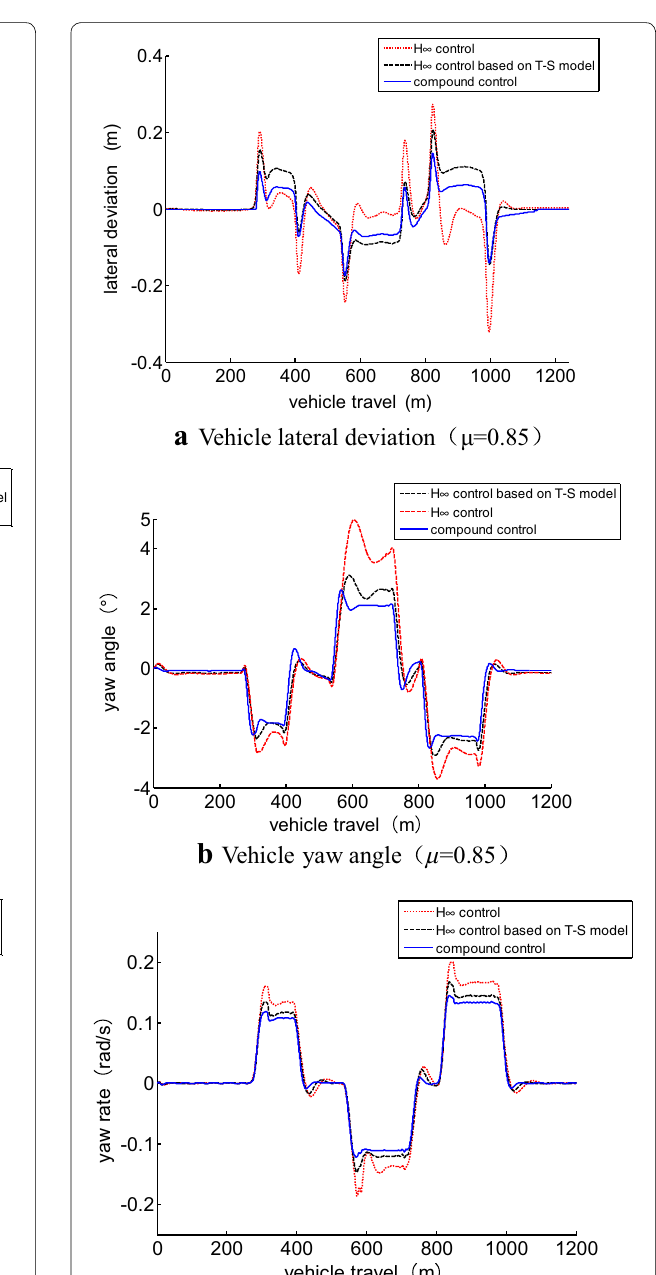
Figure 11 Vehicle driving situation on high road adhesion